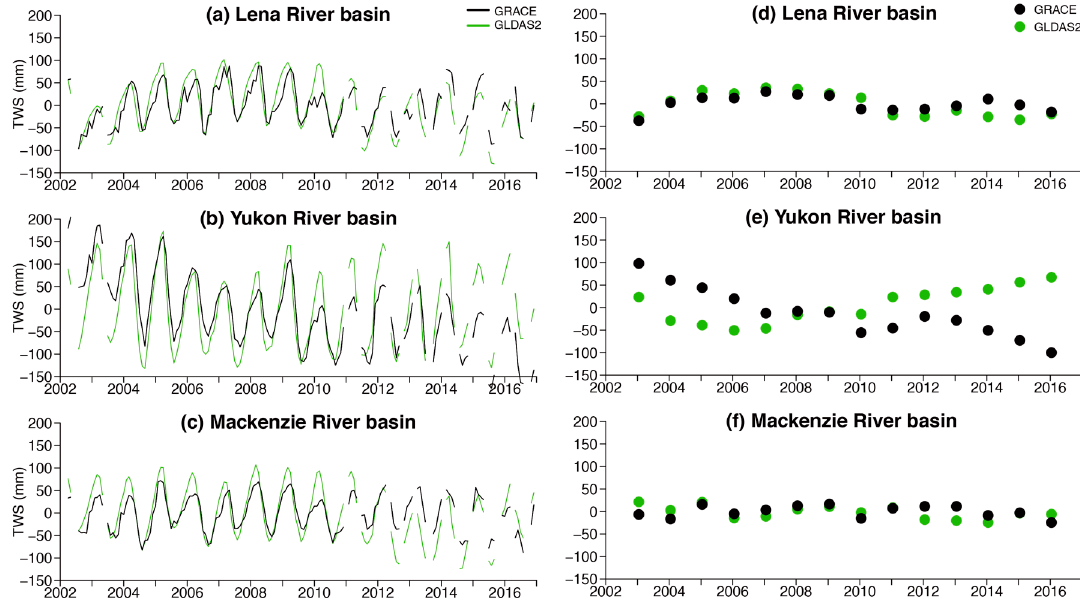
Figure 6. Temporal variations in TWS among the largest pan-Arctic river basins from 2002 to 2016. ( a – c ) Monthly and ( d – f ) annual mean values. ( a , d ) Lena River basin. ( b , e ) Yukon River basin. ( c , f ) Mackenzie River basin.